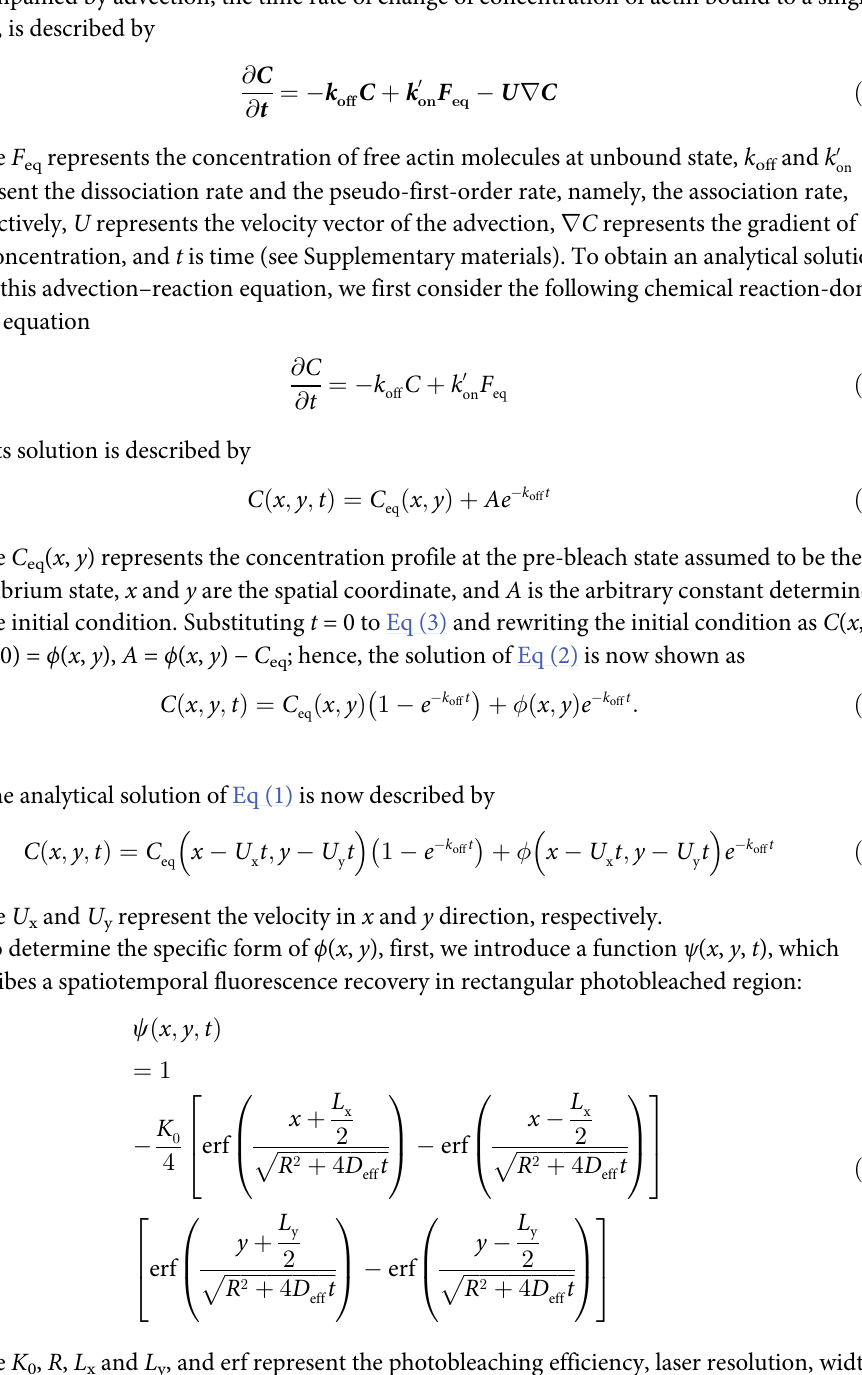
ffiffiffiffiffiffiffiffiffiffiffiffiffiffiffiffiffiffiffiffiffiffi R 2 þ 4 D